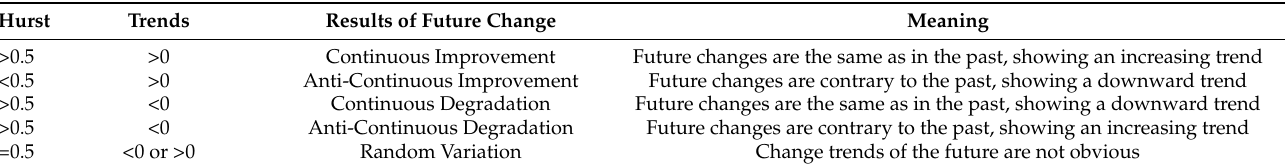
Table 1. Hurst variation characteristics based on trend